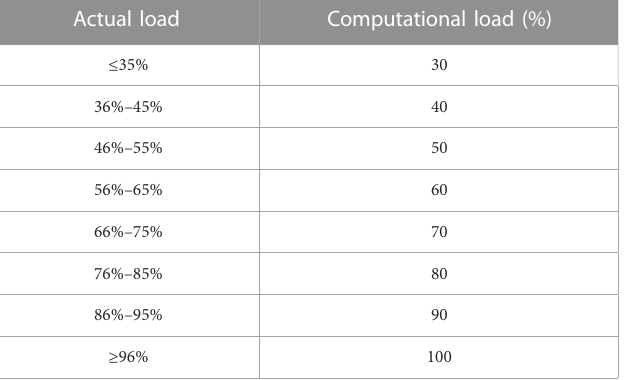
TABLE 1 Comparison of actual load and calculated